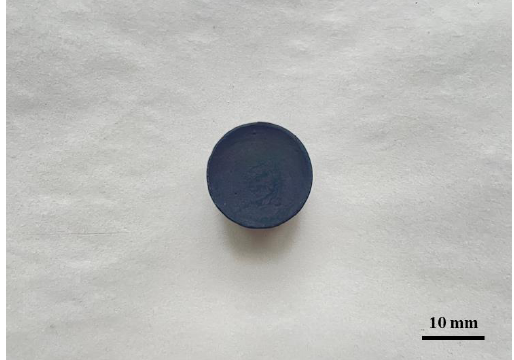
Figure 6. Photograph of a porous NiTi specimen sintered at 1050 °C for 30 min.